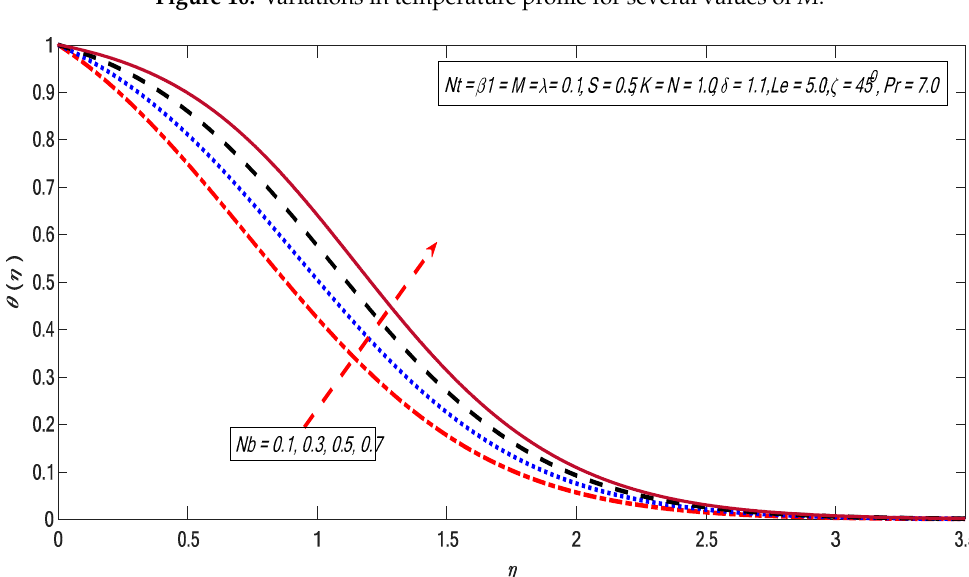
Figure 11. Variations in temperature profile for several values of 𝑁𝑏 .